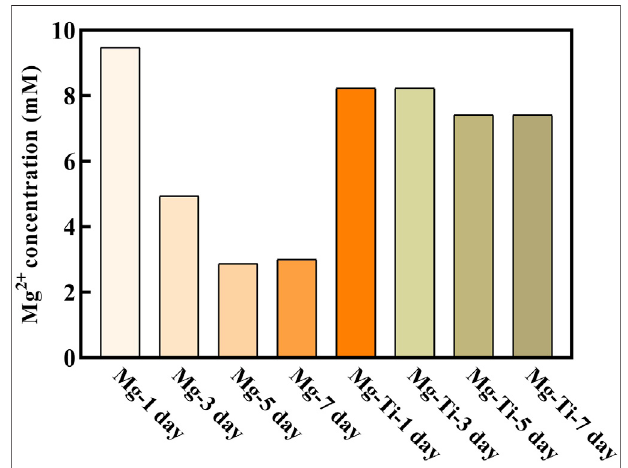
Frontiers in Bioengineering and Biotechnology |